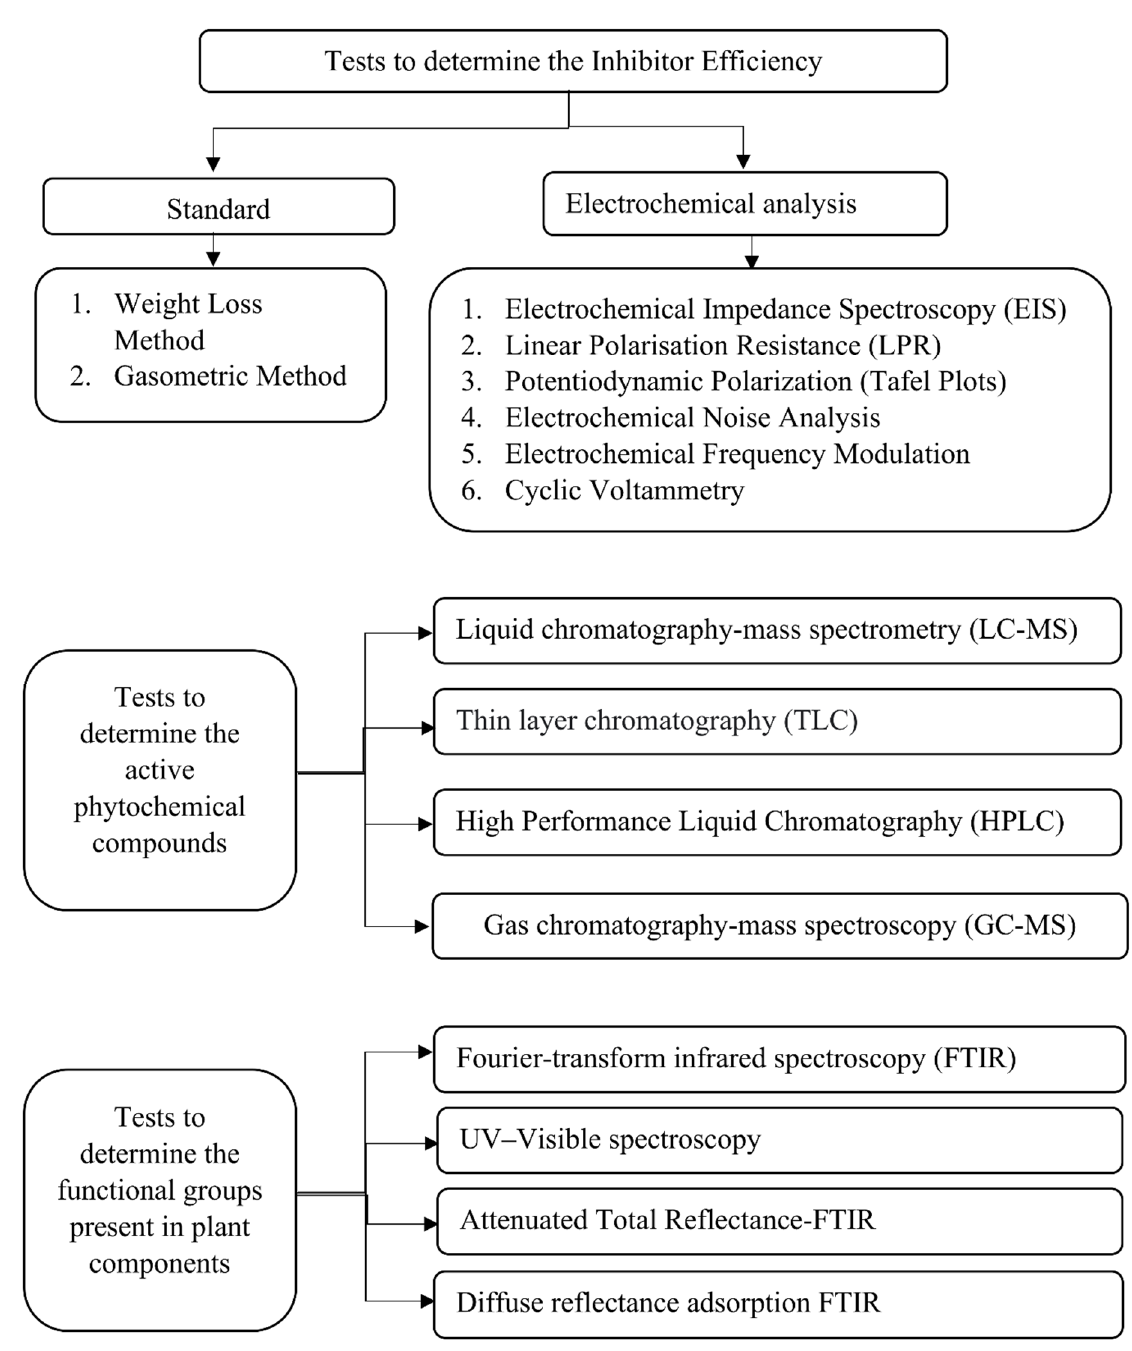
Figure 8. Tests to conduct to determine the active phytochemical compounds, functional groups in plant components and tests to determine inhibitor efficiency. Surface coverage estimates are helpful in gauging of inhibitor features and are useful for fitting experimental data to adsorption isotherms, which provides precise perspective about the inhibition mechanism